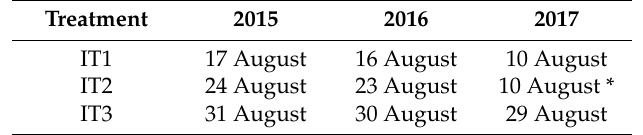
Table 3. Dates of actual irrigation termination (IT) for each treatment and year.